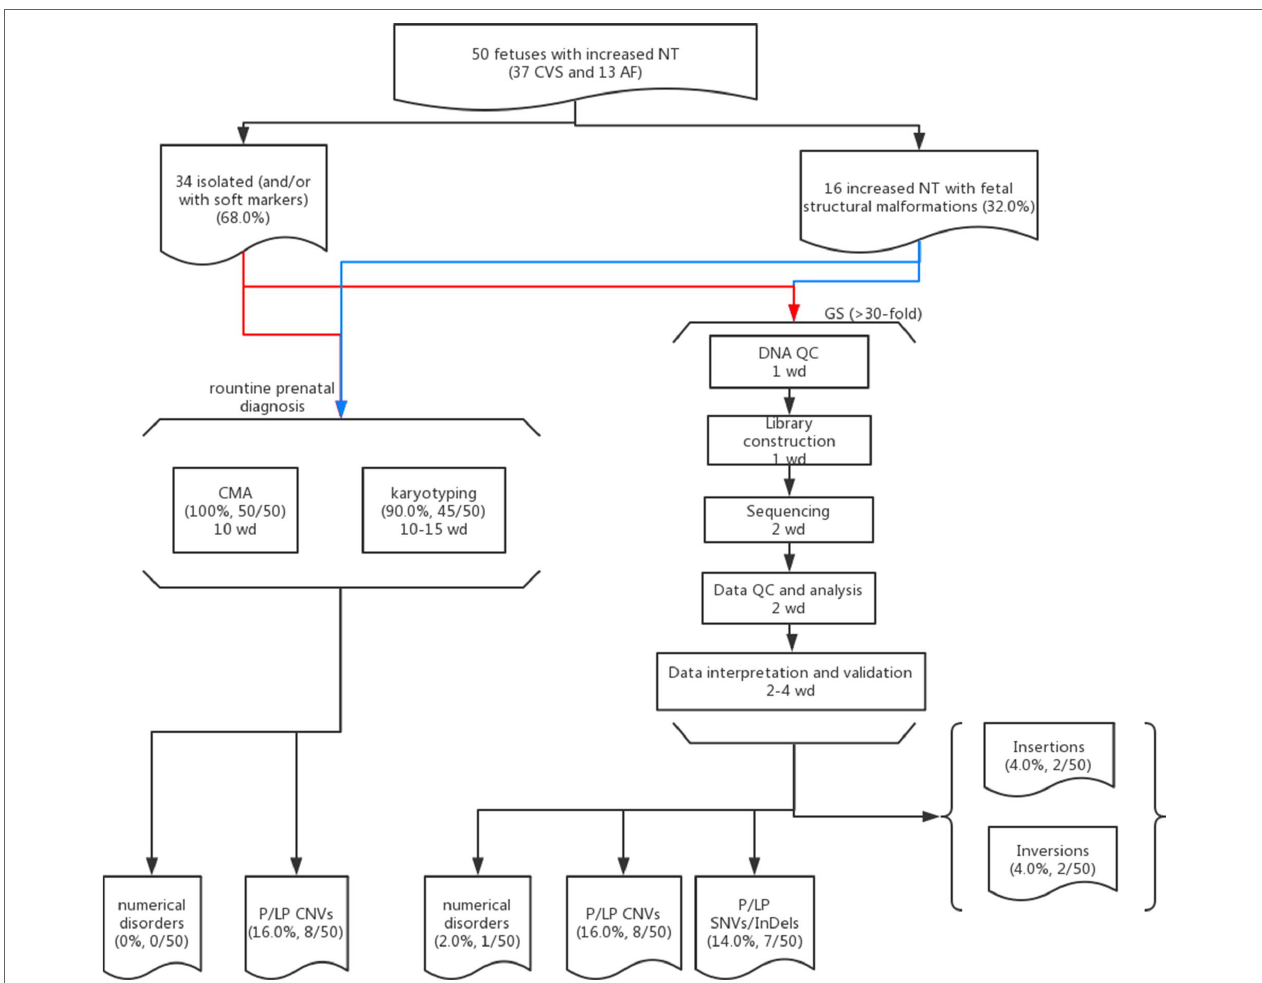
FIGURE 1 | Flowchart of this study. Detailed methods and results are described in the main text. Fifty cases with isolated (red lines) or syndromic increased NT (blue lines) and prenatal diagnosis results available (CMA and karyotyping) were selected for GS. The detailed procedures with the estimated turnaround time expressed as working day (wd) are provided in each